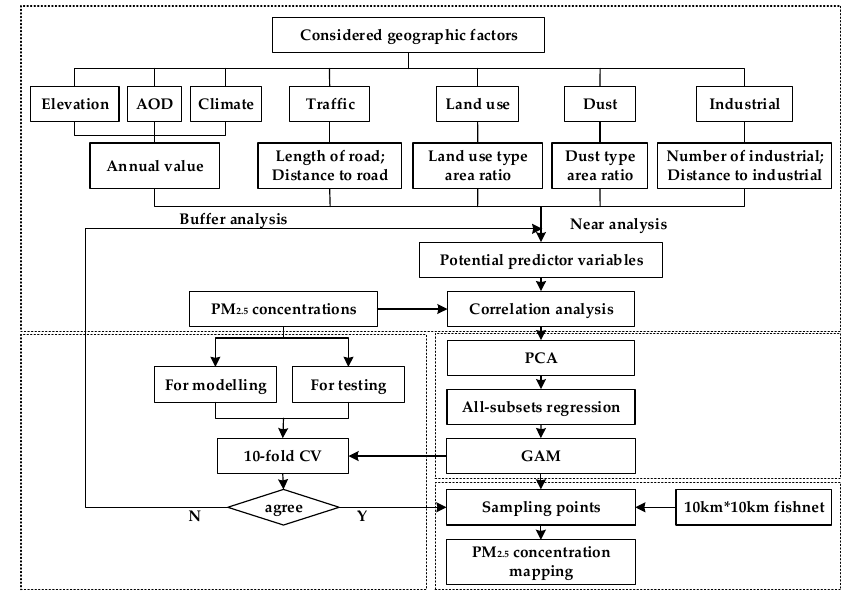
Figure 2. Framework of the study procedure.